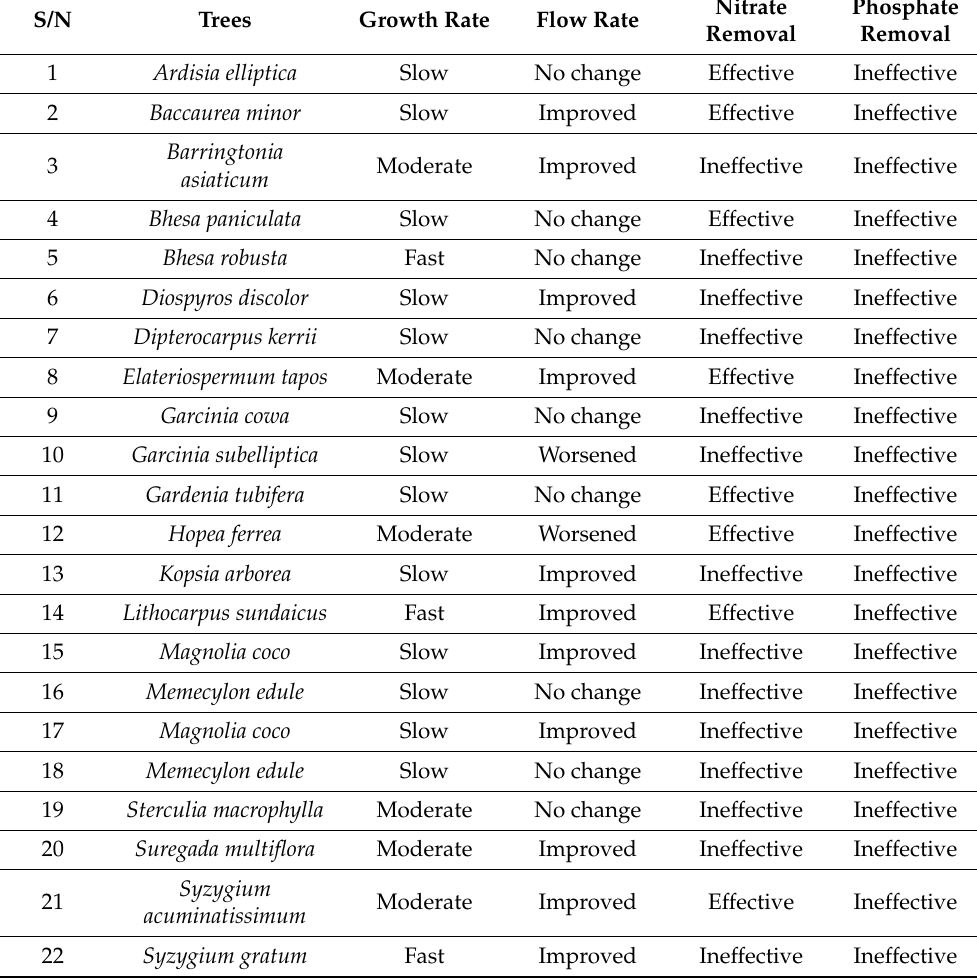
Table A1. Summary of tree species screened for suitability for bioretention tree system. S/N Trees Growth Rate Flow Rate